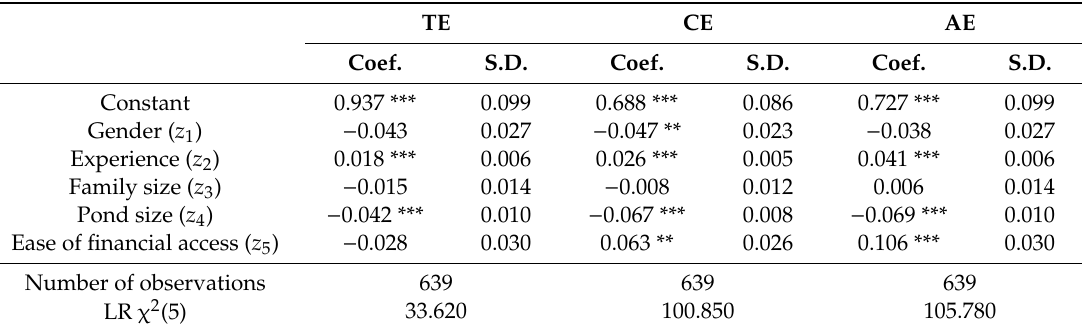
Table 3. Determinants of Red River Delta fish farms’